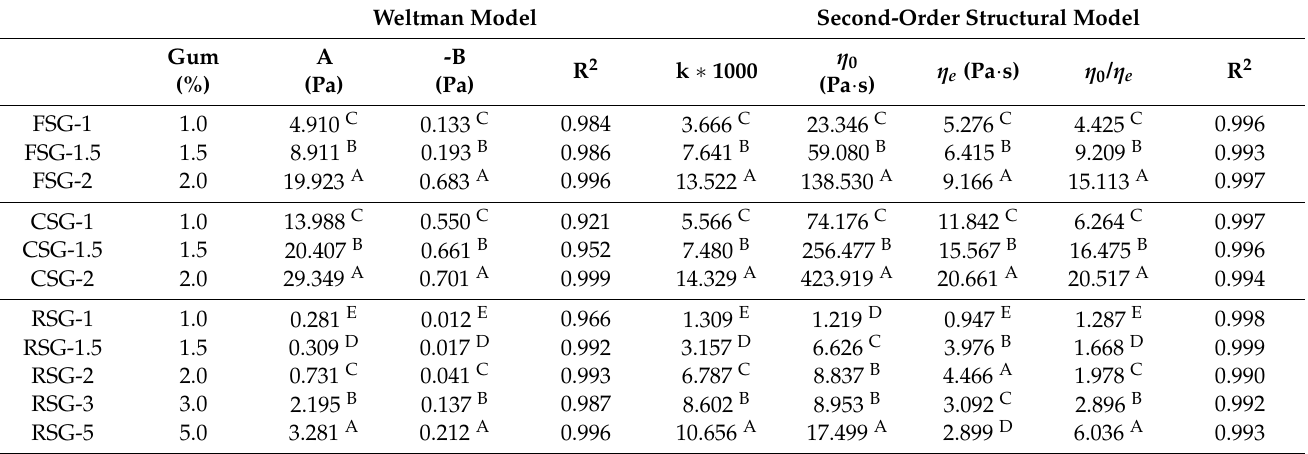
Table 3. Weltman and second-order structural kinetic model parameters defining the time-dependent flow behavior of gum solutions at 25 ◦ C.